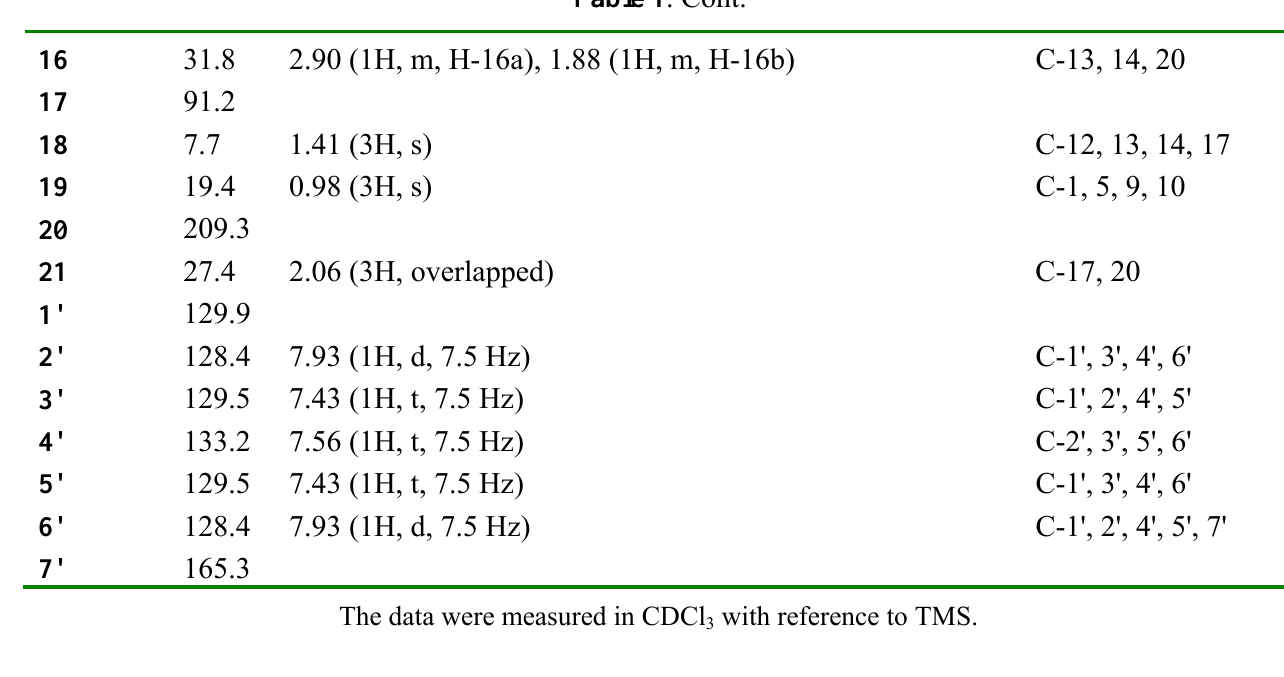
Table 2. IC values for inhibition of human cell lines of compounds 1 and 50